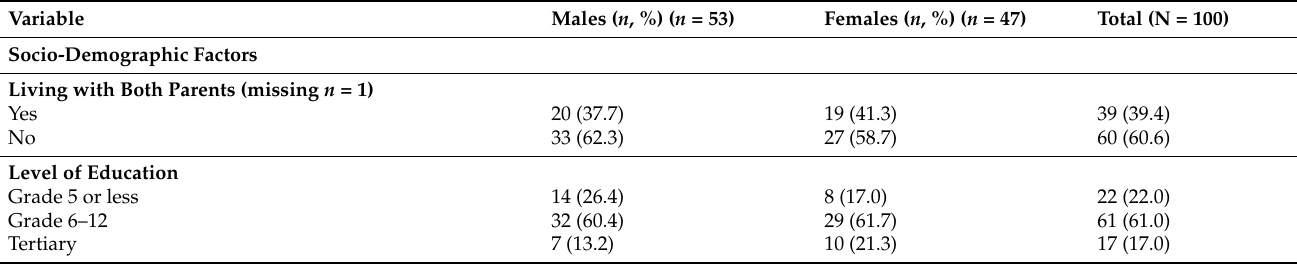
Table 1. Description of socio-demographic and psychosocial characteristics of study participants stratified by